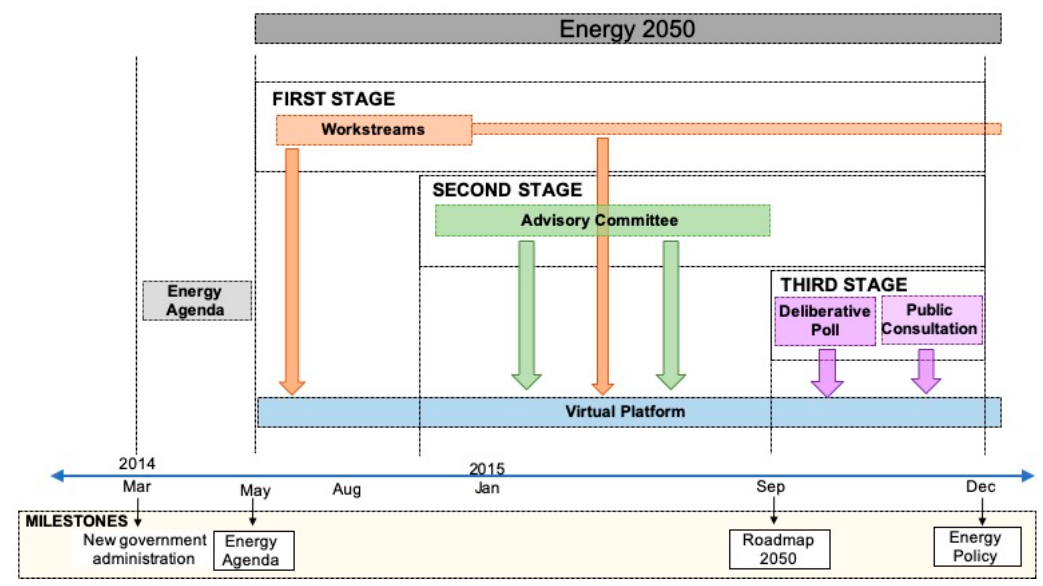
Figure 1. The Energy Policy timeline.